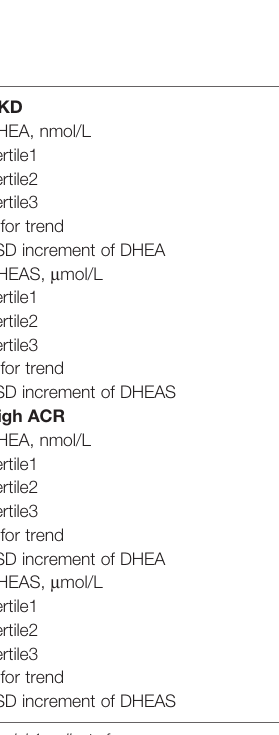
TABLE 3 | Odds ratios of DKD among women by different status of DHEA and DHEAS.